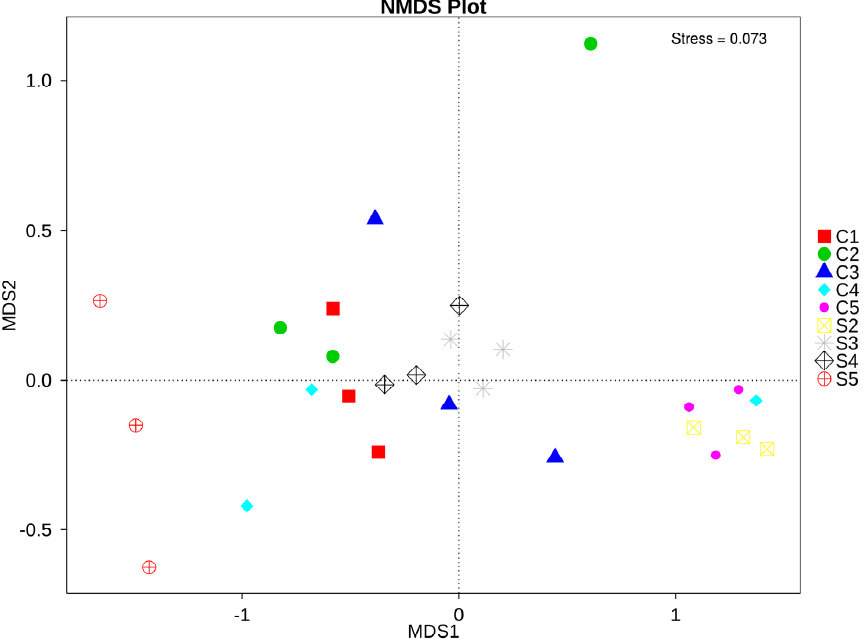
Figure 3. Nonmetric Multidimensional Scaling (NMDS) plot of the control and treatment groups. Patterns of different shapes and colors represent different samples, each point in the diagram represents one sample, and samples from the same group are represented by the same patterns.